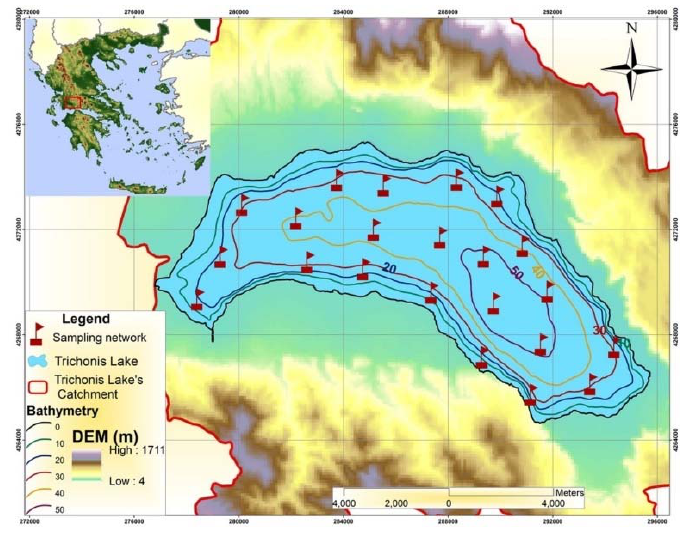
Figure 1. Trichonis Lake’s bathymetry and chl ‐ a and nutrients’ sampling network of late October 2013 and late August 2014.